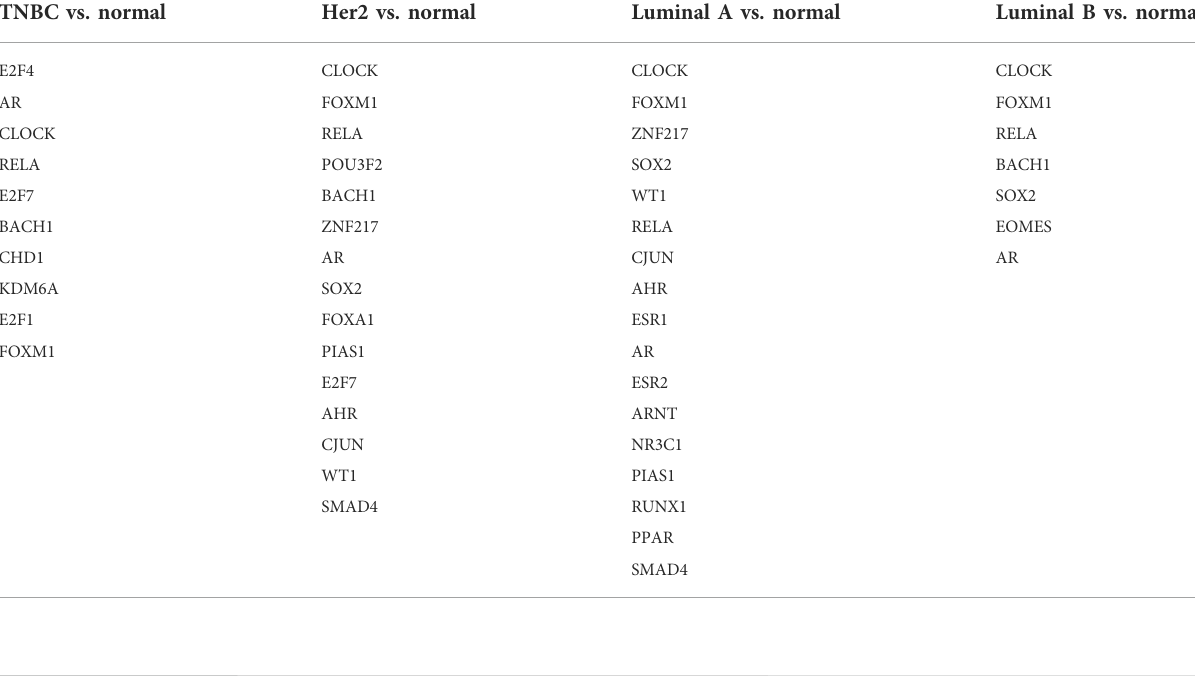
TABLE 2 Transcription factor enrichment analysis.